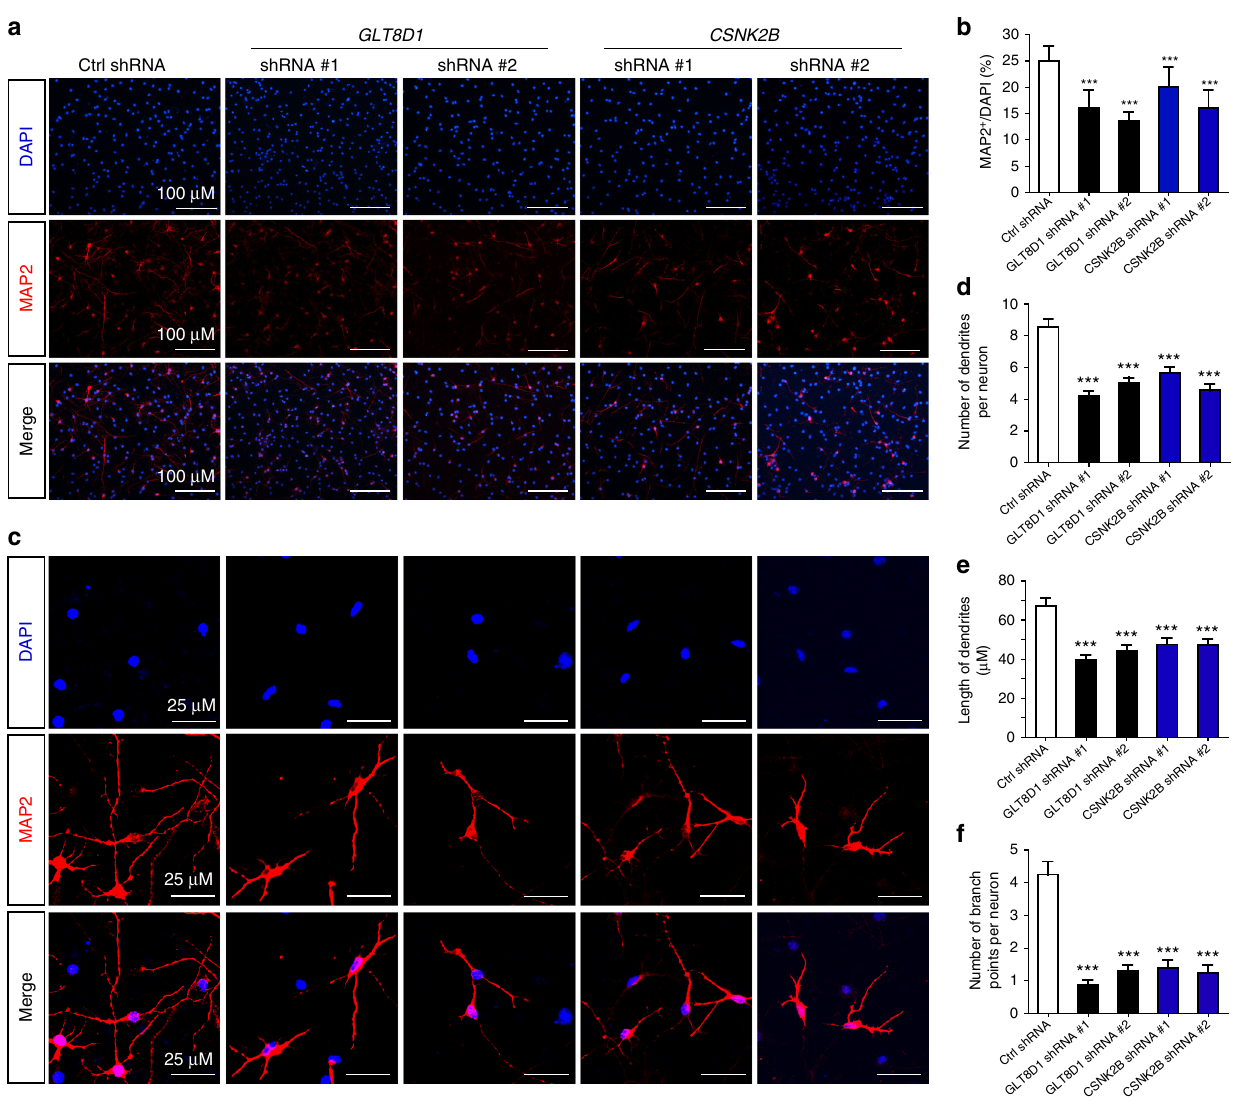
Fig. 5 Knockdown of GLT8D1 and CSNK2B lead to defects in dendritic morphology. a Representative immunostainings for MAP2 (a marker for neurons) in indicated cells. b Quanti fi cation data for a . c – f Knockdown of GLT8D1 and CSNK2B led to defects in dendritic growth. Compared with controls, the number of dendrites, the dendritic length, and branch points were signi fi cantly reduced in neurons differentiated from NSCs that stably expressing shRNAs targeting GLT8D1 and CSNK2B . A total of 60 neurons were measured for the control and experimental groups. Data in b represent mean ± SD. Data in d – f represent mean ± SEM. *** P < 0.001, two-tailed Student ’ s t